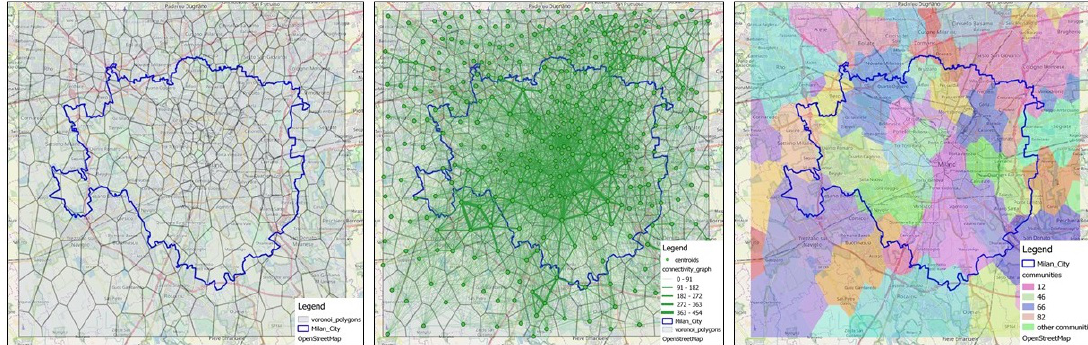
Figure 7. From coverage area to telecom data graphs and